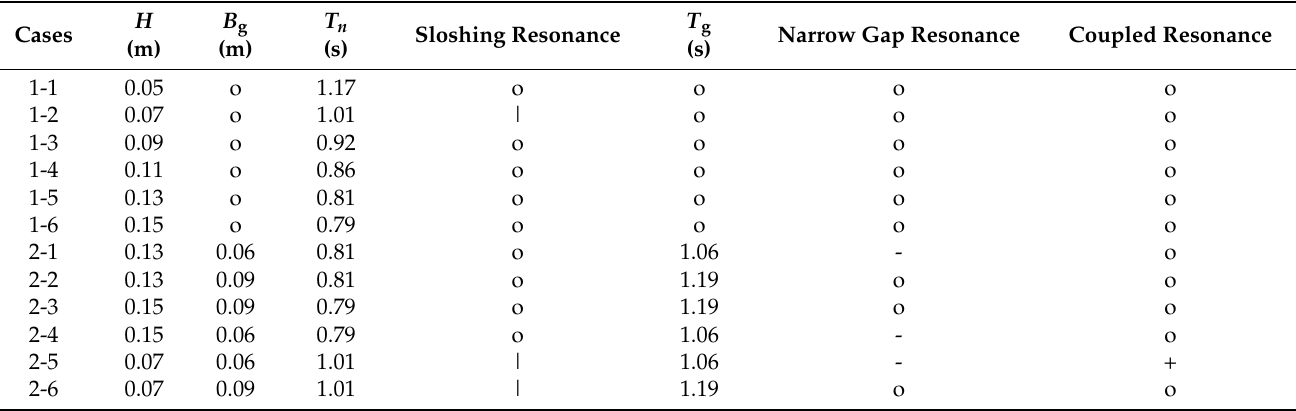
Table 1. Parameters arrangement of the test